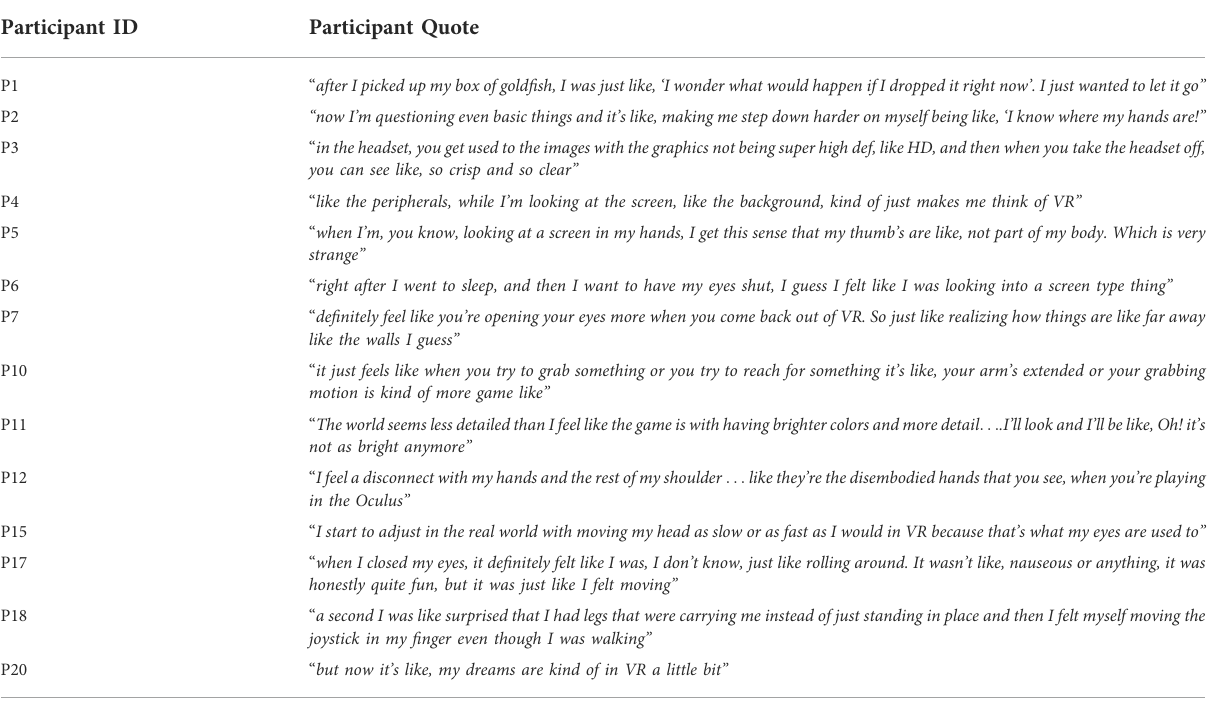
TABLE 1 Participant quotes that highlight a variety of lingering effects that were